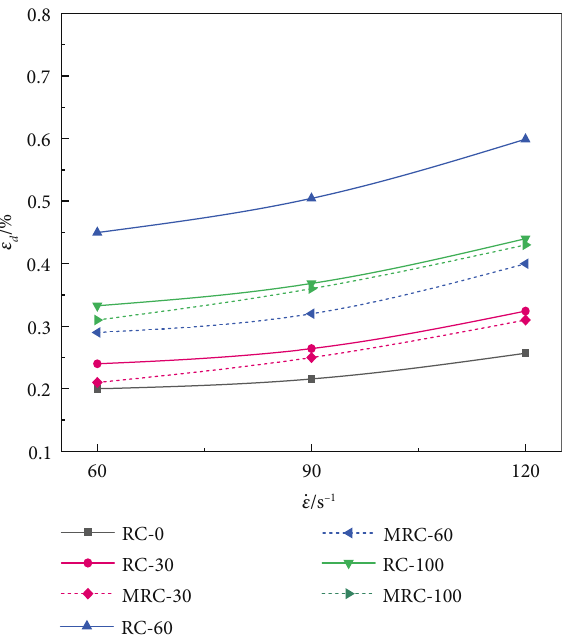
Figure 6: Relationship between dynamic peak strain and the strain rate.